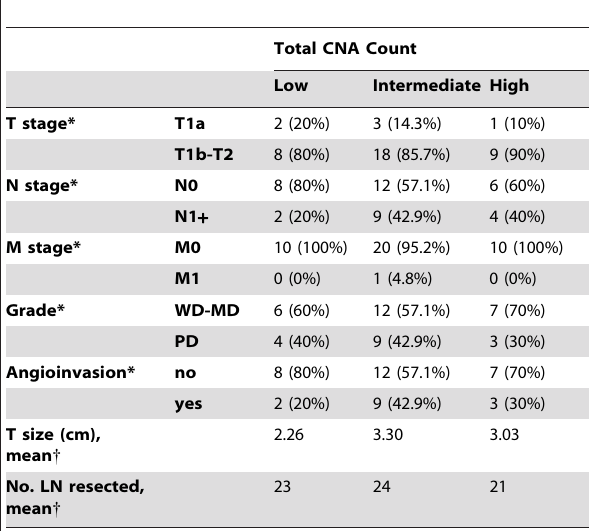
Table 3. Total CNA Count in Relation to Potential Pathologic Prognostic